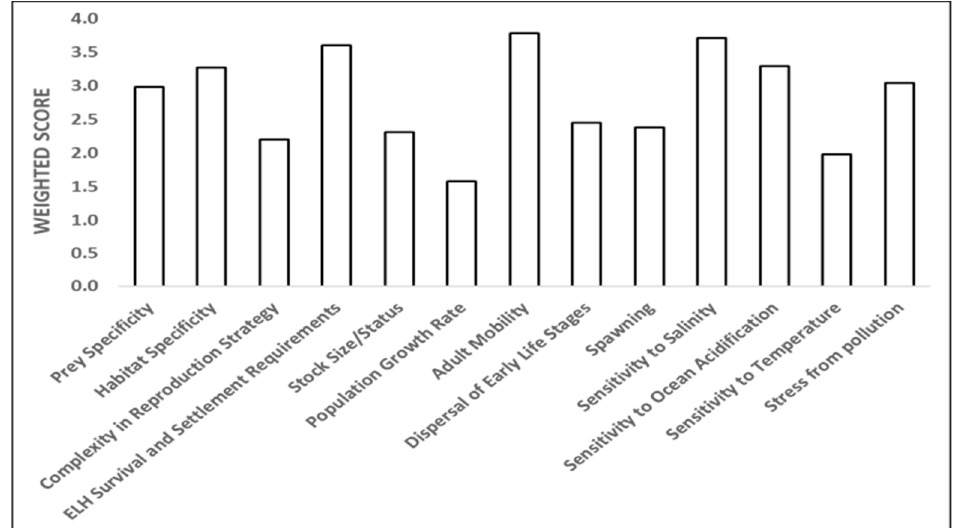
Figure 5. Average scores estimated for climatic exposures and sensitivity attributes for samples. Bootstrapped analysis of the scores indicates very high certainties in scores (>95%).